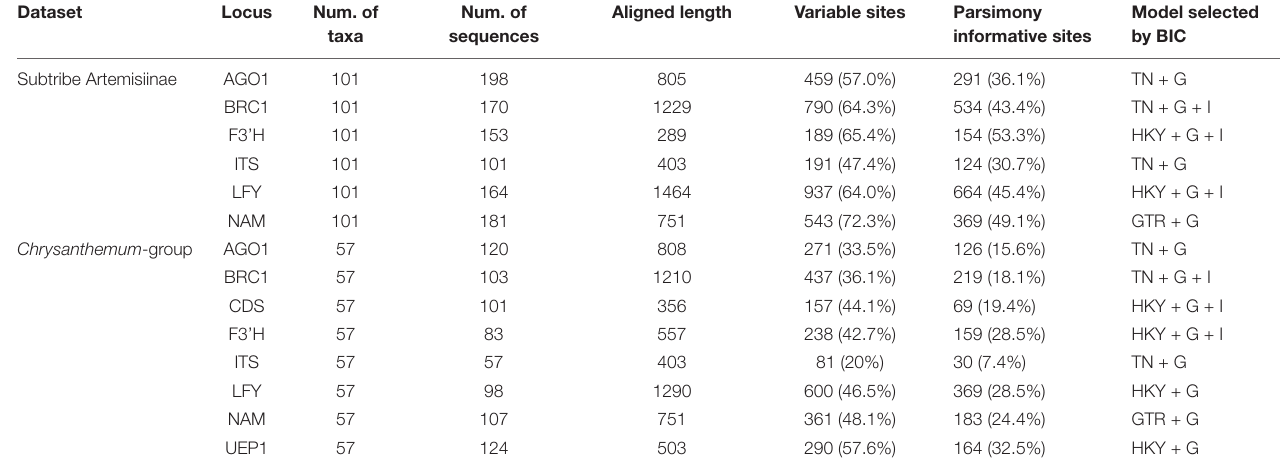
Num. of Aligned length Variable sites Parsimony taxa sequences